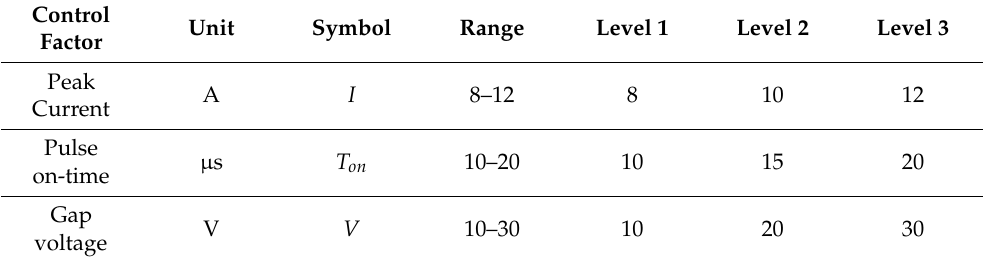
Table 1. WEDM parameters and their levels.